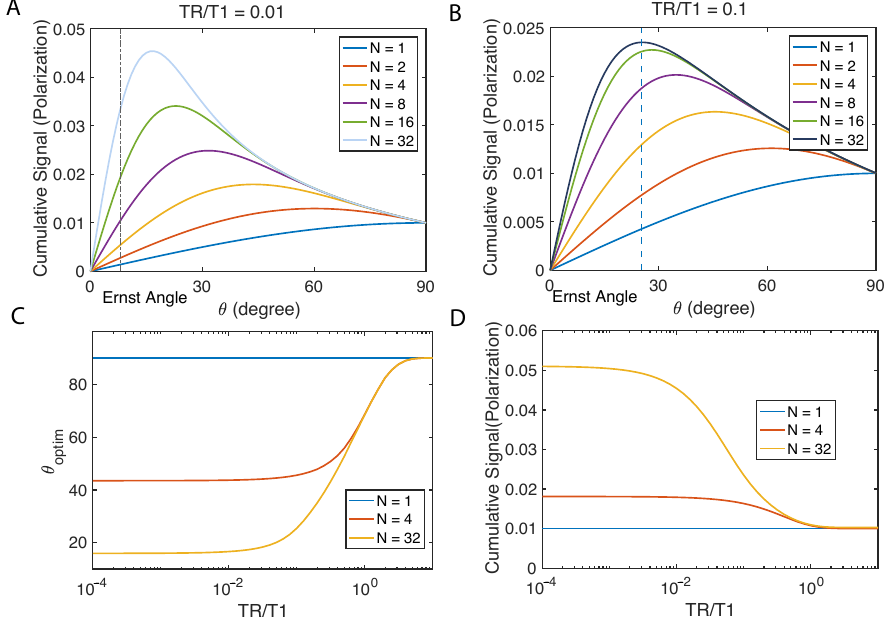
Figure 3. Constant flip angle. In the simulation, K hp = 10 − 3 and K 0 = 10 − 5 , which is on the same orders of magnitude of magnetization with our diamond imaging case at 9.4T. ( A ) Cumulative signal with different total repetitions N is displayed when the ratio of TR/T1 is fixed. The black dash line is the Ernst angle, optimal for initial magnetization to be M 0 . ( B ) Fixing the ratio TR/T1, we simulate the cumulative signal with different N . ( C ) Optimal flip angles and ( D ) resultant cumulative signals when such angle is restricted to a constant are shown as a function of